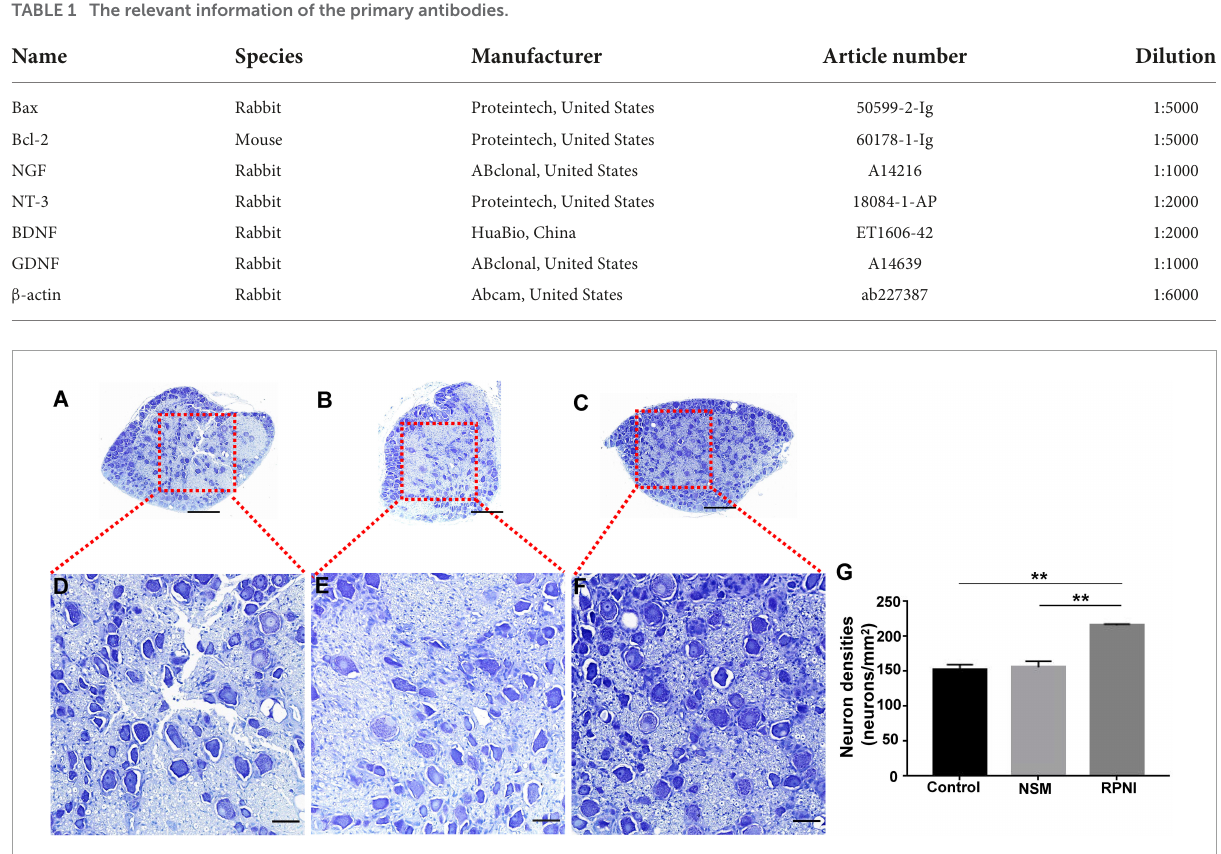
FIGURE2 The results of neuron counting in the ipsilateral L4 DRG among the three groups at 8 weeks post-axotomy. (A–F) Toluidine blue-stained neuronal cell bodies within the ipsilateral L4 DRG in the control (A,D) , NSM (B,E) and RPNI (C,F) groups. Regions marked with red boxes in panels (A–C) are depicted at a higher magnification in panels (D–F) . (G) Neuron densities of the ipsilateral DRGs in each group. [** p < 0.01. Scale bar = 100 µ m (A–C) , Scale bar = 25 µ m (D–F) ]. DRG, dorsal root ganglia; NSM, nerve stump implantation inside the muscle; RPNI, regenerative peripheral nerve